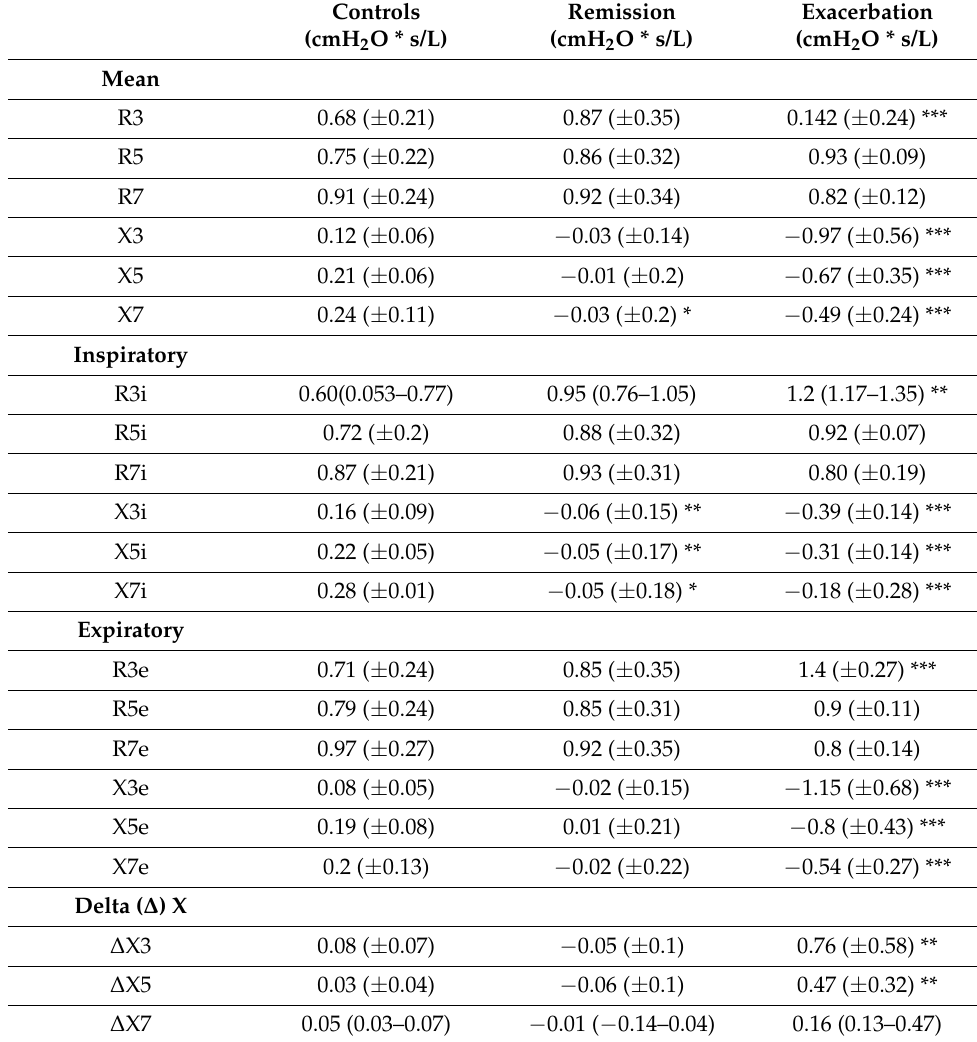
Table 1. Results of IOS measurement in the three group. Normally distributed data are displayed as mean ± standard deviation. Non-normal distributed values are presented as median and